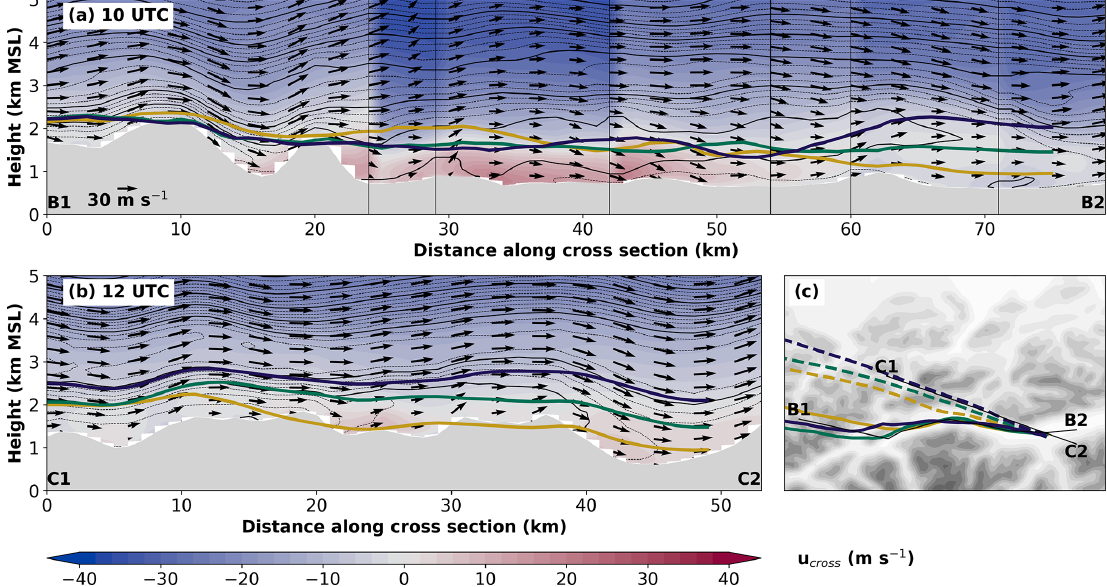
Figure 12. Vertical transect of equivalent potential temperature and wind along (a) CS_LTA at 10:00UTC and (b) CS_WST at 12:00UTC on 29 October 2017 and median trajectory height selected by the arrival height in Innsbruck and the dominant section where the trajectories cross the Inn Valley boundary. Black contour lines and wind vectors are as in Fig. 5. Color contours represent horizontal wind component perpendicular to the transect (positive into the plain). Discontinuities in (a) are caused by kinks in the transect (see alignment in c ). Lines indicate median trajectory height projected to the transect for trajectories crossing section II in (a) and section III in (b) . Line colors indicate the trajectory arrival heights as in Fig. 11. Topographic map in (c) with median trajectory position for trajectories arriving via section II at 10:00UTC (thick solid lines) and section III at 12:00UTC (thick dashed lines). Thin black lines indicate the location of the cross sections, and text labels illustrate the start and end points of the